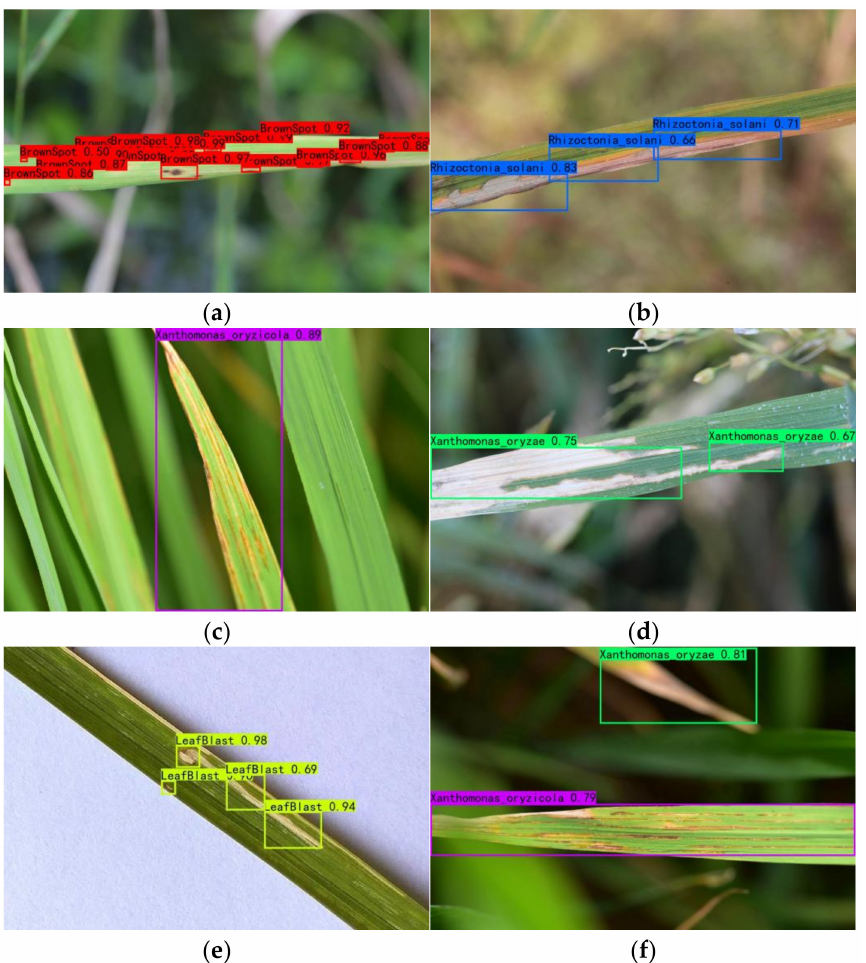
Figure 8. Spot detection test results. ( a ) In the red box is hoary leaf spot; ( b ) in the blue box is stripe blight; ( c , f ) in the purple box is stripe disease; ( d , f ) in the green box is white leaf blight; ( e ) in the green box is rice leaf